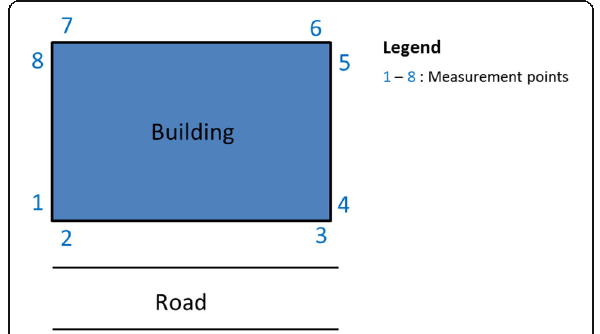
Fig. 6 Measurement points of the building